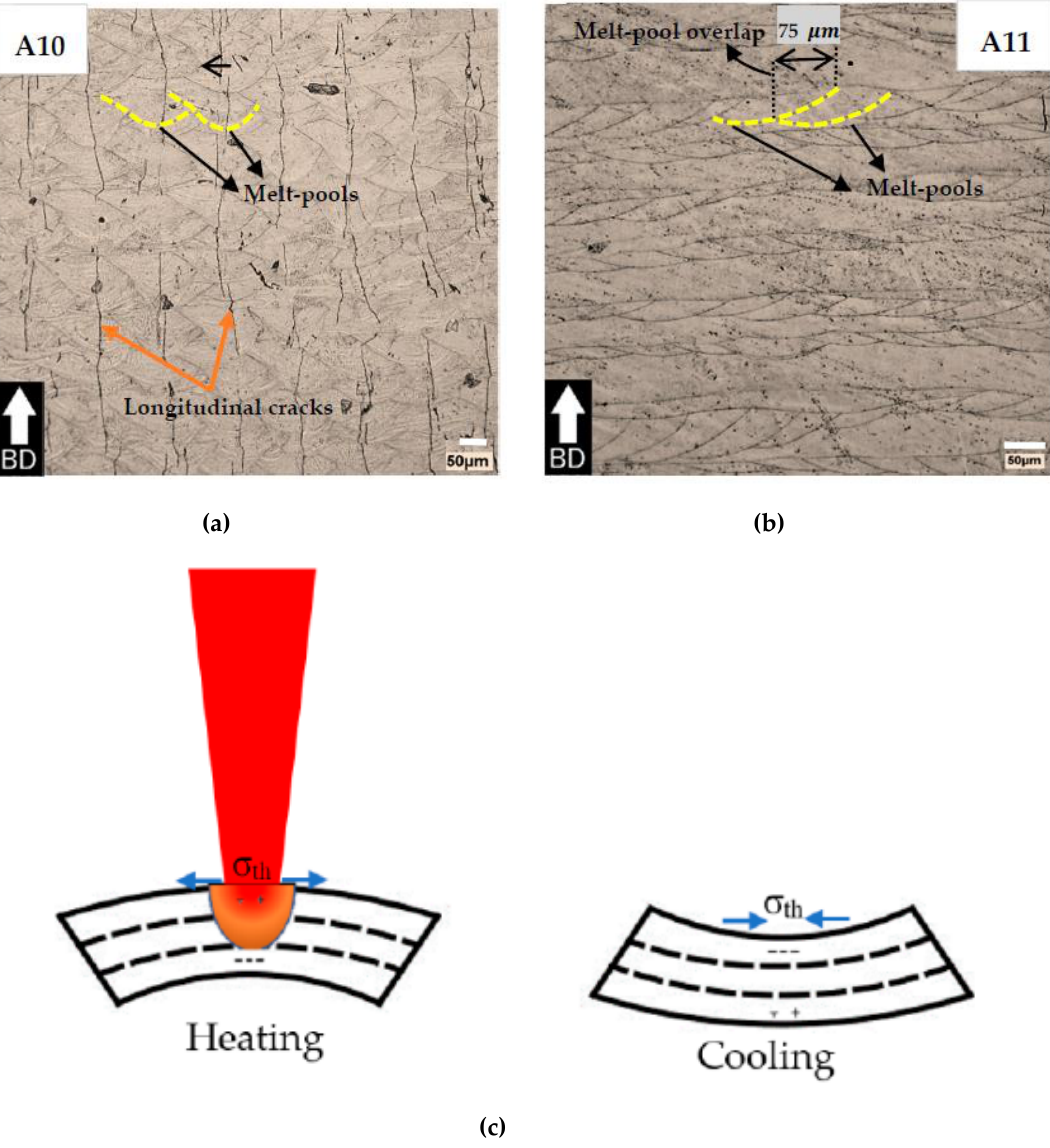
Figure 3. Optical images from the build direction showing ( a ) sample A10 with long cracks along the BD, ( b ) crack-free micrograph of sample A11, and ( c ) schematics of heating and cooling stages in the temperature gradient mechanism as a probable cause of cracks.